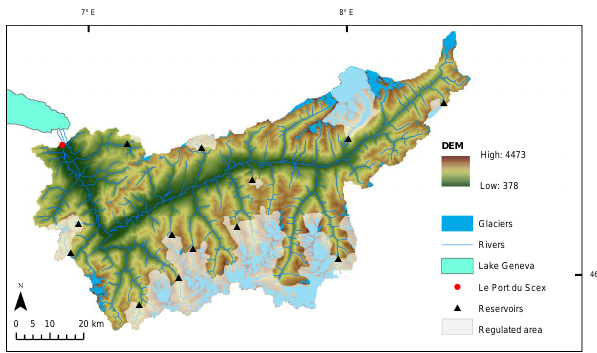
Figure 1. Map of the upper Rhône Basin with topography, glacier- ized areas, and river network. The measurement station Porte du Scex, located just upstream where the Rhône River enters the Lake Geneva, is indicated with a red marker. The main 13 reservoirs con- sidered in this study are represented with black triangles and the regulated fraction of the catchment is highlighted with a light grey shaded